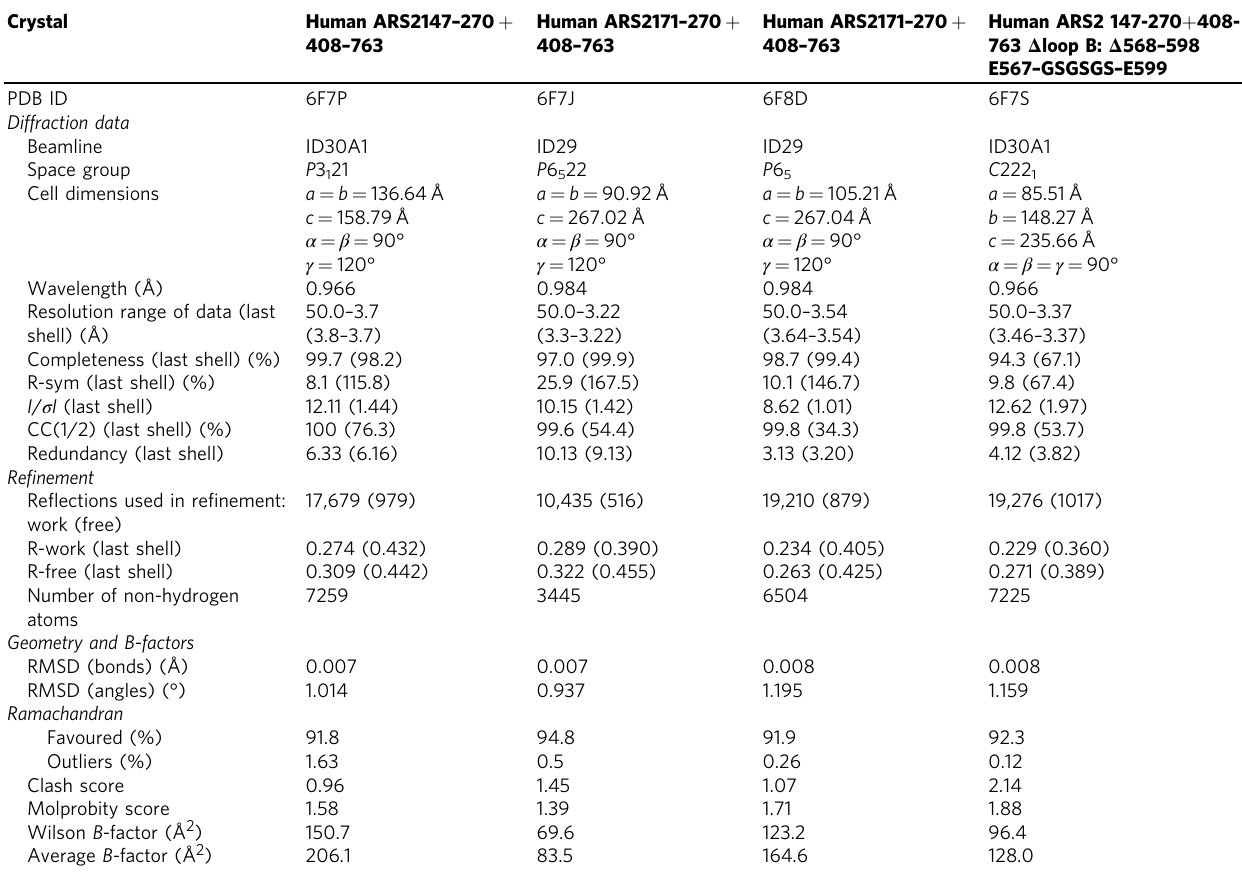
Table 1 Crystallographic data collection and re fi nement statistics